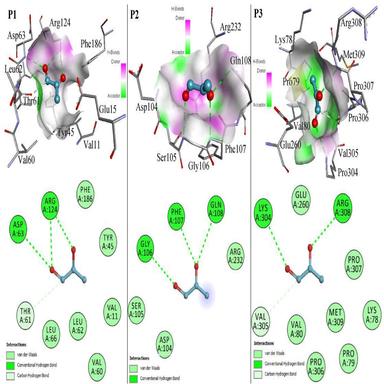
Interactions of MG to hTF (a) 3D view of binding pocket residues of hTF interacting with methylglyoxal. (b) 2D diagram of hTF residues interacting with methylglyoxal. P1-P3 are predicted binding pockets where methylglyoxal is binding with different poses and interactions.